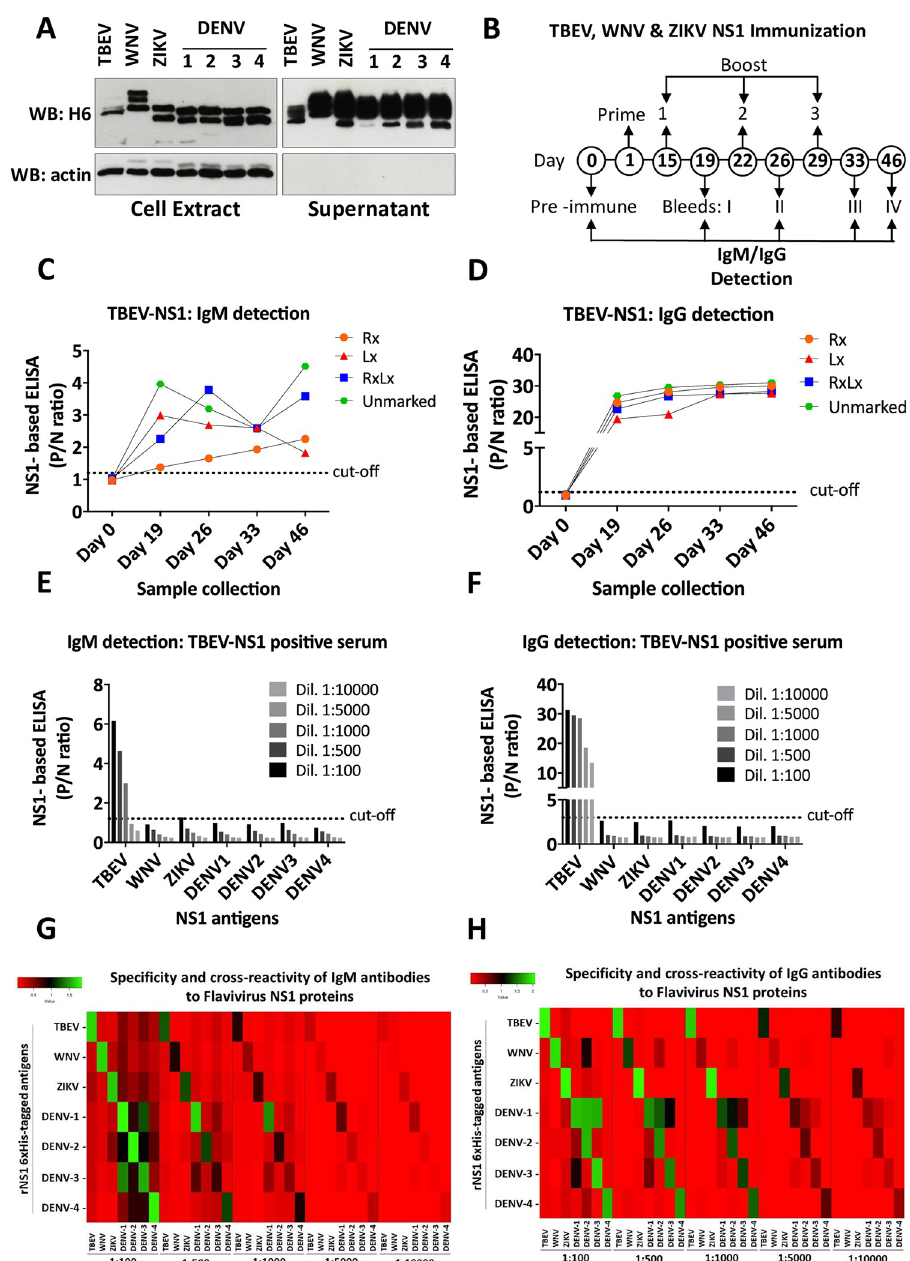
Fig 2. Validation of rNS1 antigens by ELISA in immunized mice. A) Expression and secretion of V5-tagged recombinant NS1 proteins of TBEV, WNV, ZIKV, and DENV1-4 in cell extract and supernatant of transfected HEK293T cells. Actin blots were included as a loading control for cell extracts and of clean supernatants. SDS PAGE was conducted in denaturing/reducing conditions. B) Schematic representation of the protocol followed for the immunization of BALB/c mice by gene gun technology. Numbers indicate the day when the prime-boost immunization was performed and the day of collection. C and D) TBEV rNS1 IgM/IgG ELISA with sera from four different mice immunized with TBEV-NS1 (mice were differentiated with a mark in the right ear (Rx), left (Lx), both ears (RxLx) or without the mark (unmarked)). Detection of IgM/IgG antibodies was performed at day 0, 19, 26, 33 and 46. E and F) TBEV, WNV, ZIKV, and DENV1-4 IgM/IgG rNS1 ELISA with sera from TBEV-NS1 immunized mice. Sera from day 46 post-immunization were diluted in blocking solution (2% milk in PBS) as indicated. G and H) Heatmaps of the IgM/IgG cross-reactivity. Several dilutions of each serum sample were analyzed in plates coated with homologous and heterologous rNS1 6xHis-tagged antigens. � each ELISA result includes the average of two biological